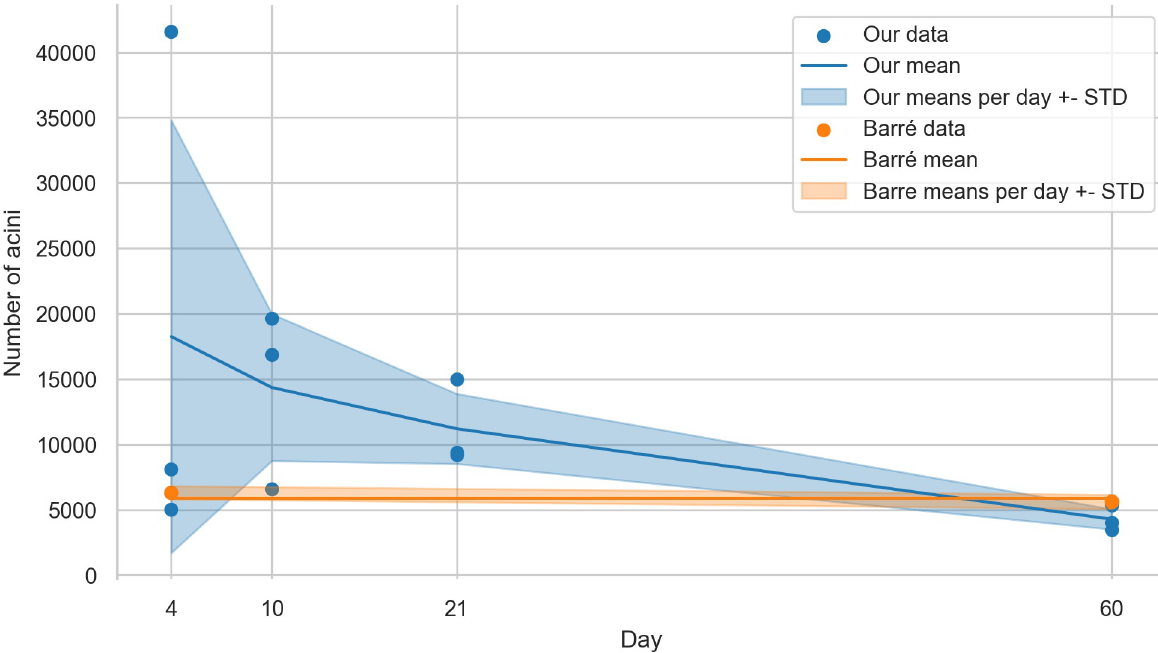
Fig 7. Plot of the estimated number of acini. The blue plot shows our estimation, based on the division of the parenchymal volume by the average volume of the acini. The orange plot is based on the data shown by Barre´ et al. [10, 11].